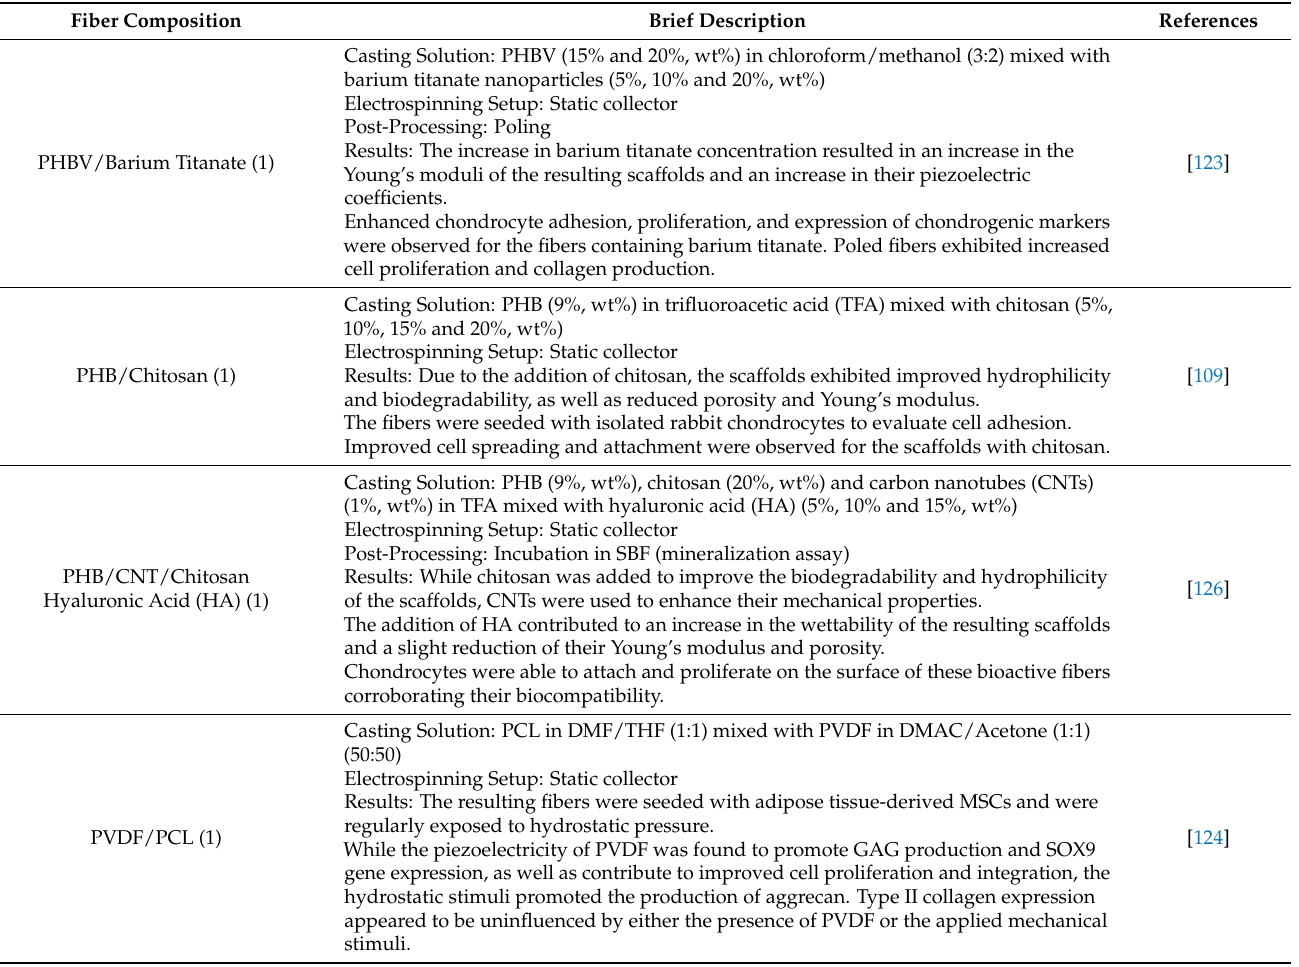
Table 7. Examples of piezoceramic or PZP-based electrospun piezoelectric nanofibers described in the literature for articular cartilage (1) and osteochondral (2) TE